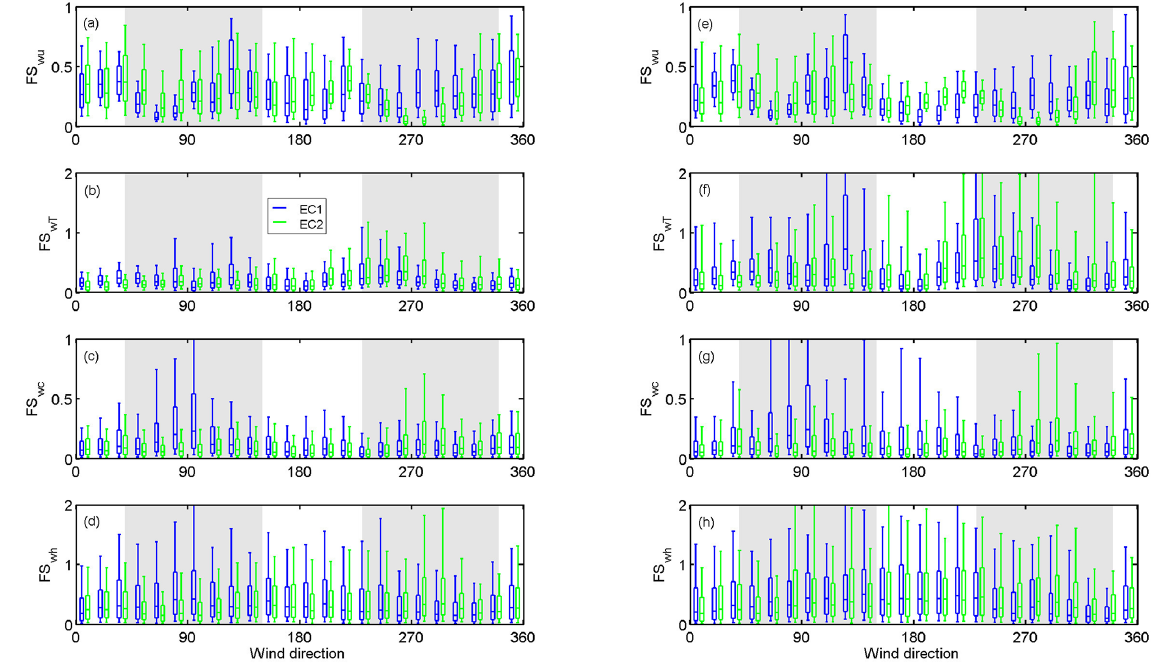
Figure 9. Stationarity (FS) of (a, e) vertical wind speed ( w ), (b, f) air temperature ( T ), (c, g) CO 2 ( c ) and (d, h) water vapour ( h ) as a function of wind direction for hours 06:00–21:00 (a) – (d) and 21:00–06:00 (e) – (h) for EC1 (blue) and EC2 (green) during July 2013 until September 2015. Whiskers and boxes represent the 10th, 25th, 50th, 75th and 90th